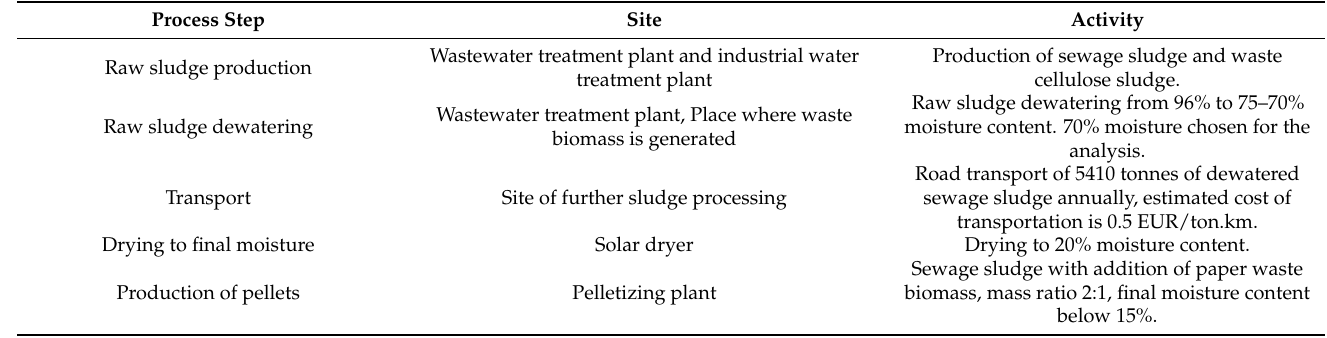
Table 1. Main steps in the technology of fuel production from sewage sludge and waste